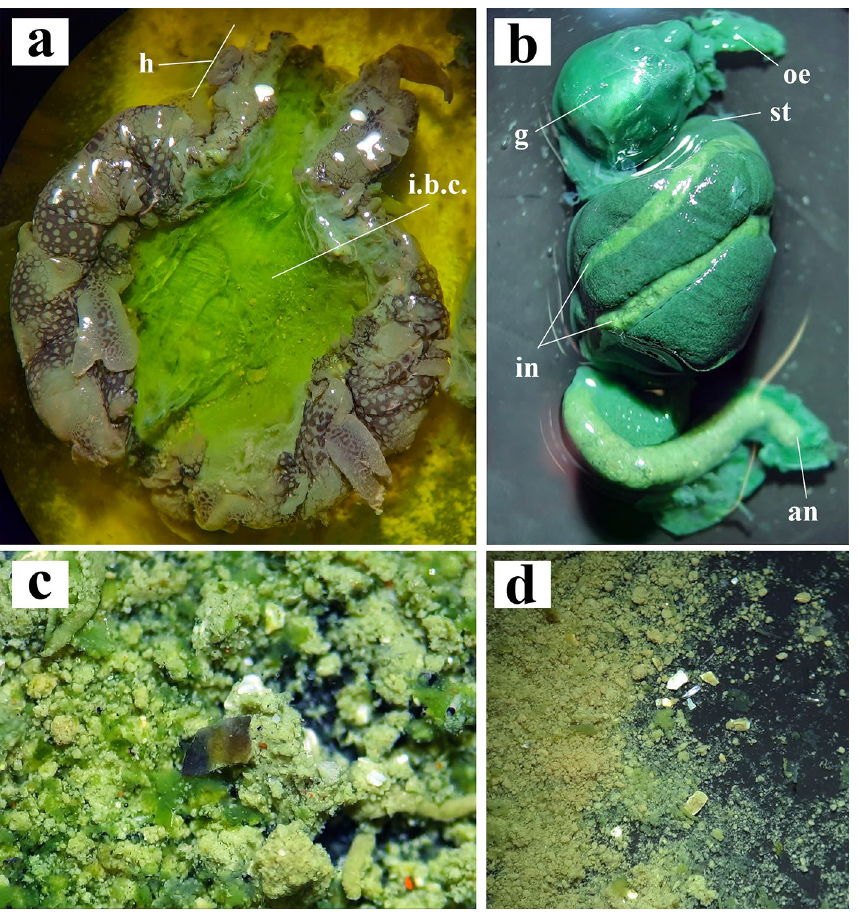
Figure 3. Anatomical dissection of Bursatella leachii . ( a ) Dorsal view of the body after removal of the internal visceral mass. ( b ) The digestive apparatus (oesophagus, gizzard, stomach, intestine, anus) separated from the rest of the body. ( c , d ) Images showing the stomach content where are visible the small microplastic debris. an anus, g gizzard, h head, i.b.c. internal body cavity, in intestine, oe